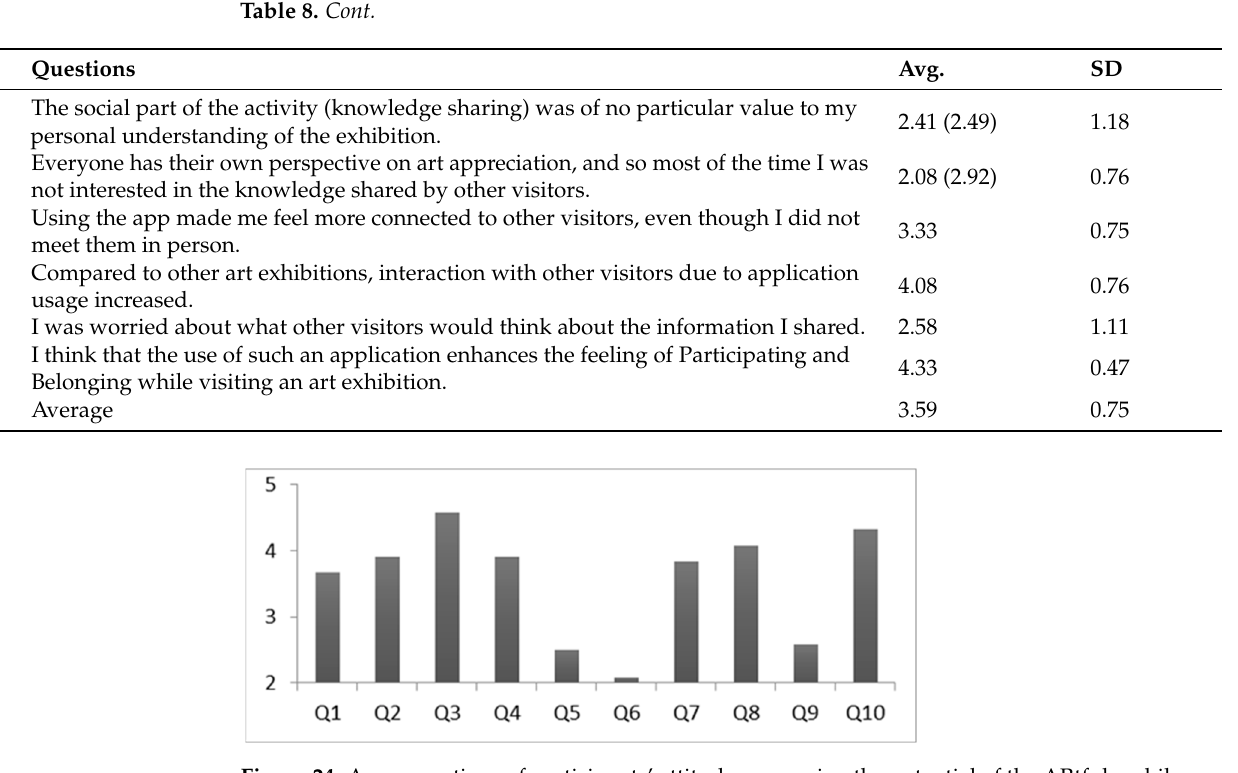
Figure 24. Average ratings of participants’ attitude concerning the potential of the ARtful mobile